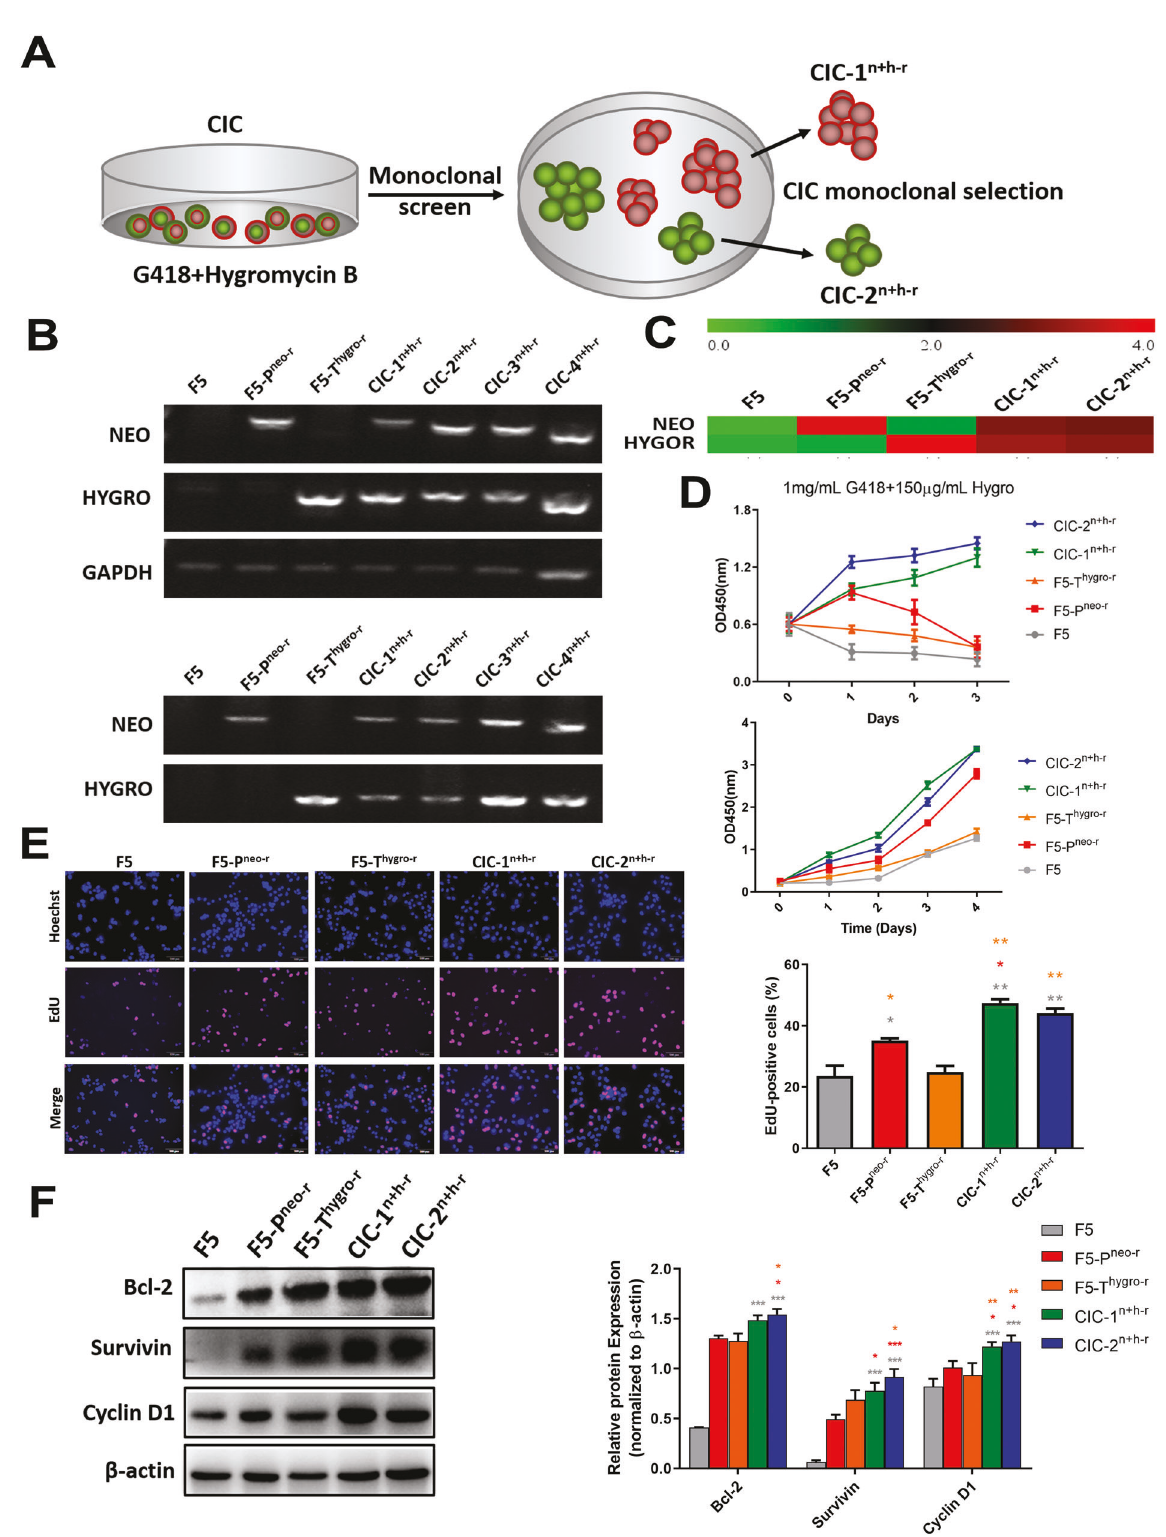
Fig. 3 The dual-antibiotic-resistant CIC derivative exhibited signi fi cant proliferation ability. A Schematic diagram of CICs monoclonal in medium with both G418 and hygromycin B. B Detecting the neomycin (NEO) or hygromycin resistance marker (HYGRO) from RNAs (upper panel) and DNAs (lower panel) extracted from F5, F5-P neo-r , F5-T hygro-r and several CIC monoclonals by PCR. C The heatmap re fl ecting log 2 (expression of NEO and HYGRO target genes) in F5, F5-P neo-r , F5-T hygro-r and CIC n + h-r cells. D The proliferation of F5, F5-P neo-r , F5-T hygro-r and CIC n + h-r cells with (upper panel) or without (lower panel) 1 mg/mL G418 and 150 μ g/mL hygro B at different time points using CCK-8 assays. E The proliferation of F5, F5-P neo-r , F5-T hygro-r and CIC n + h-r cells by Edu staining assay. F The expression of Bcl-2, Survivin, Cyclin D1 and β -actin was used as control in F5, F5-P neo-r , F5-T hygro-r and CIC n + h-r cells Western blot analysis (left). The bands of proteins were quanti fi ed by densitometry and normalized to β -actin protein (right). * P < 0.05, ** P < 0.01, *** P < 0.001. Cell Death and Disease (2023)